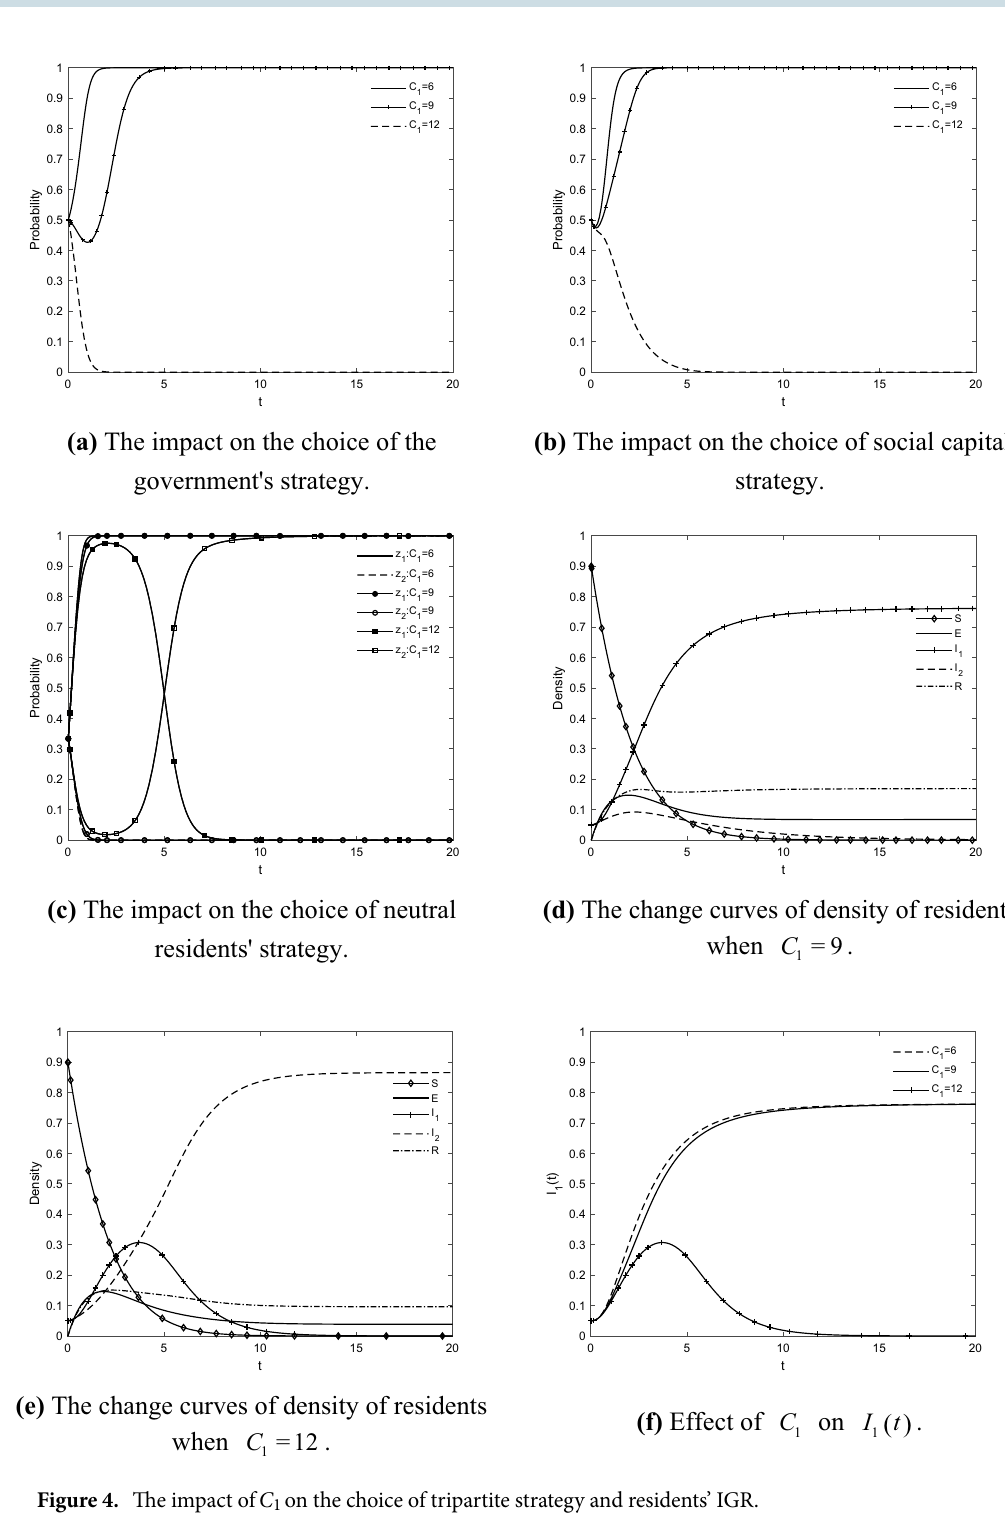
Figure 4. The impact of C 1 on the choice of tripartite strategy and residents’